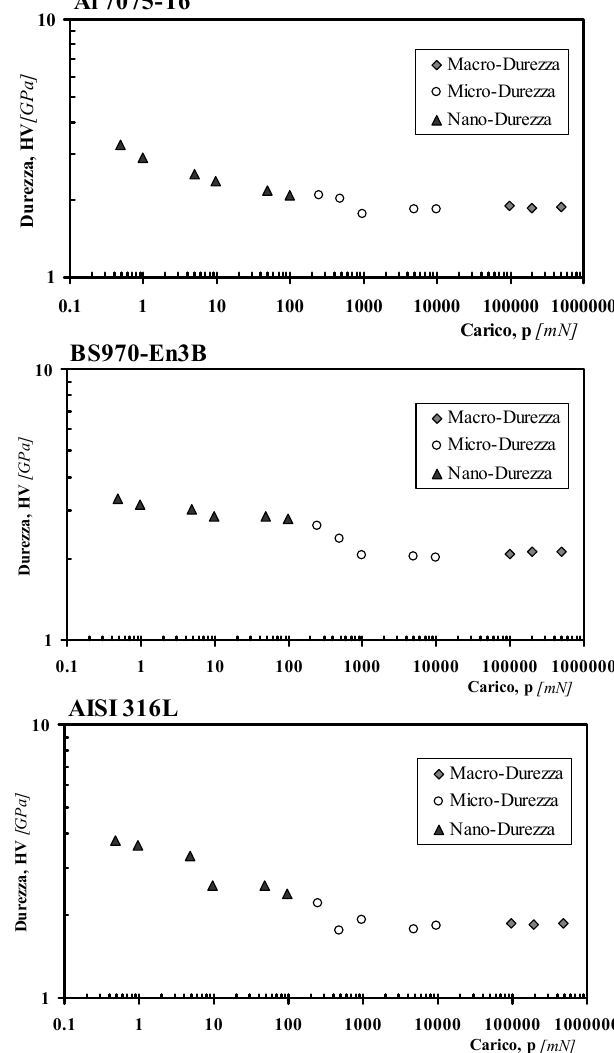
Figura 7: Risultati delle prove di durezza Vickers eseguite sui diversi materiali investigati. Figure 7: Results of the Vickers